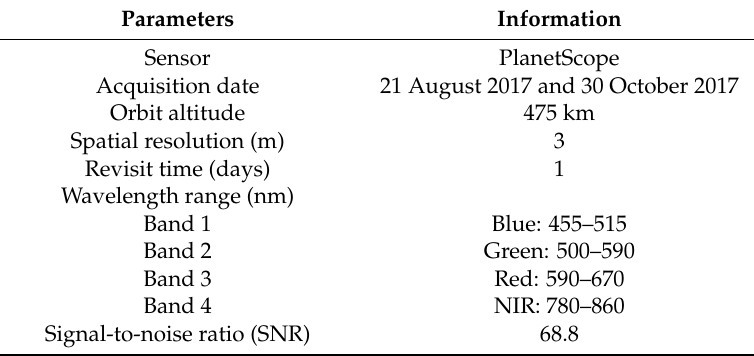
Table 1. The parameters and information for the selected PlanetScope